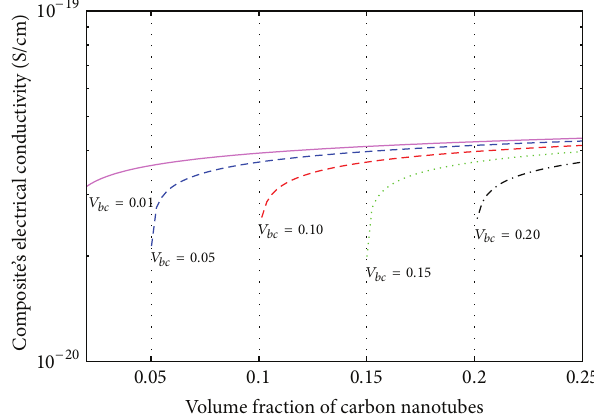
Figure 3: Sigmoidal function model for DC electrical conductivity for nanocomposites.